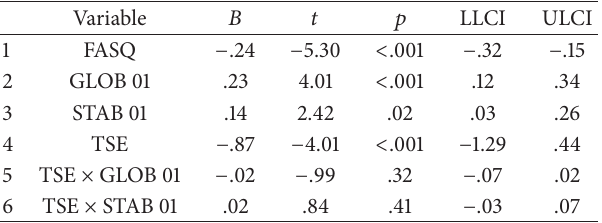
Table 3: Predicting Depressive Symptoms from the interaction between negative attributional styles and time since exacerbation of symptoms: summary of a linear mixed model.